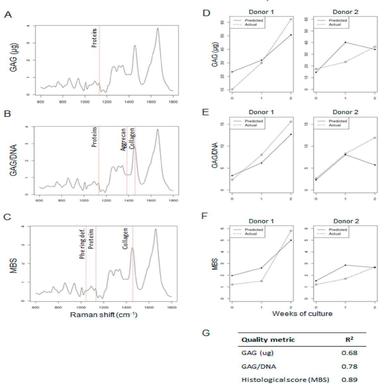
Lasso variable selection was used to select specific Raman peaks that could predict the quantified (A) GAG (μg), (B) GAG/DNA, and (C) histological MBS, and the peaks were tentatively attributed to substances). Multiple linear regression models were built using the selected peaks and (D–F) tested with Raman spectra from two additional donors. (G) R2 of the observed vs. predicted values for the test data.